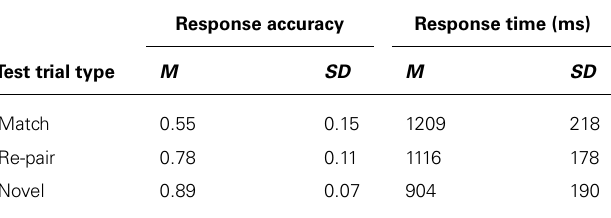
Table 1 | Proportion of correct recognition responses and response times for each trial type.